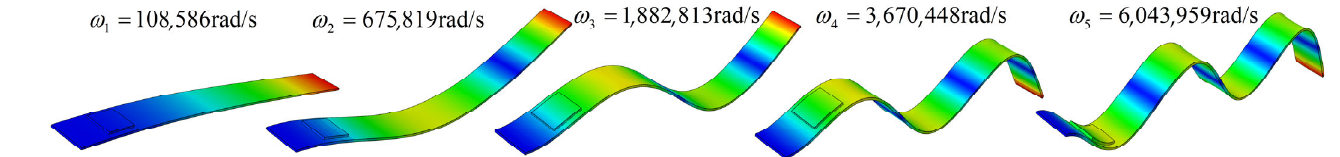
Figure 7. The FEA model of the cantilever resonator and adsorbate.